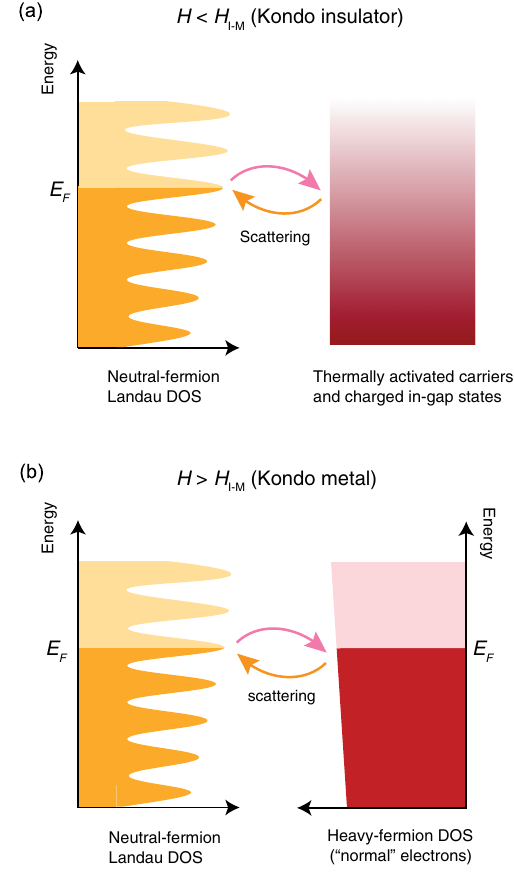
FIG. 8. Schematic of the two-fluid picture for transport in YbB 12 ; a neutral-quasiparticle Fermi surface coexists with more , the neutral quasi- conventional charge carriers. Close to E F particles may likely be represented as a linear, equal combina- tion of canonical particle and antiparticle operators. The linear coupling to the magnetic vector potential A will change their ε ½ k − ð e= ℏ Þ A (cid:2) þ wave-vector ( k ) dependent energy to E ¼ 1 2 f ε ½ k þ ð e= ℏ Þ A (cid:2)g . Thus, any linear response to A (e.g., electrical conductivity) will be zero, but effects quadratic in A (e.g., Landau quantization, and therefore, the dHvA effect) will occur. (a) In the KI state, the charge carriers are primarily thermally activated electrons and holes plus (for T ≲ 2 K) charged in-gap states including surface states, bulk impurity levels, etc. The rate of scattering between the charge carriers and the neutral quasiparticles will depend on the available DOS; hence, the Landau-level DOS of the neutral quasiparticles will cause a field-dependent modulation of the electrical transport, leading to SdH oscillations. (b) In the KM state, fermions scatter between charge-neutral Landau levels and heavy-fermion metal bands; again, the scattering occurs at a rate given by the joint fermion DOS. As the neutral-quasiparticle DOS oscillates with H , so will the transport parameters of the heavy electrons. [The heavy electrons are thought to have a mass approximately equal to 100 m 0 , and so their quantum oscillations will be thermally smeared out even at the lowest experimental T thus far